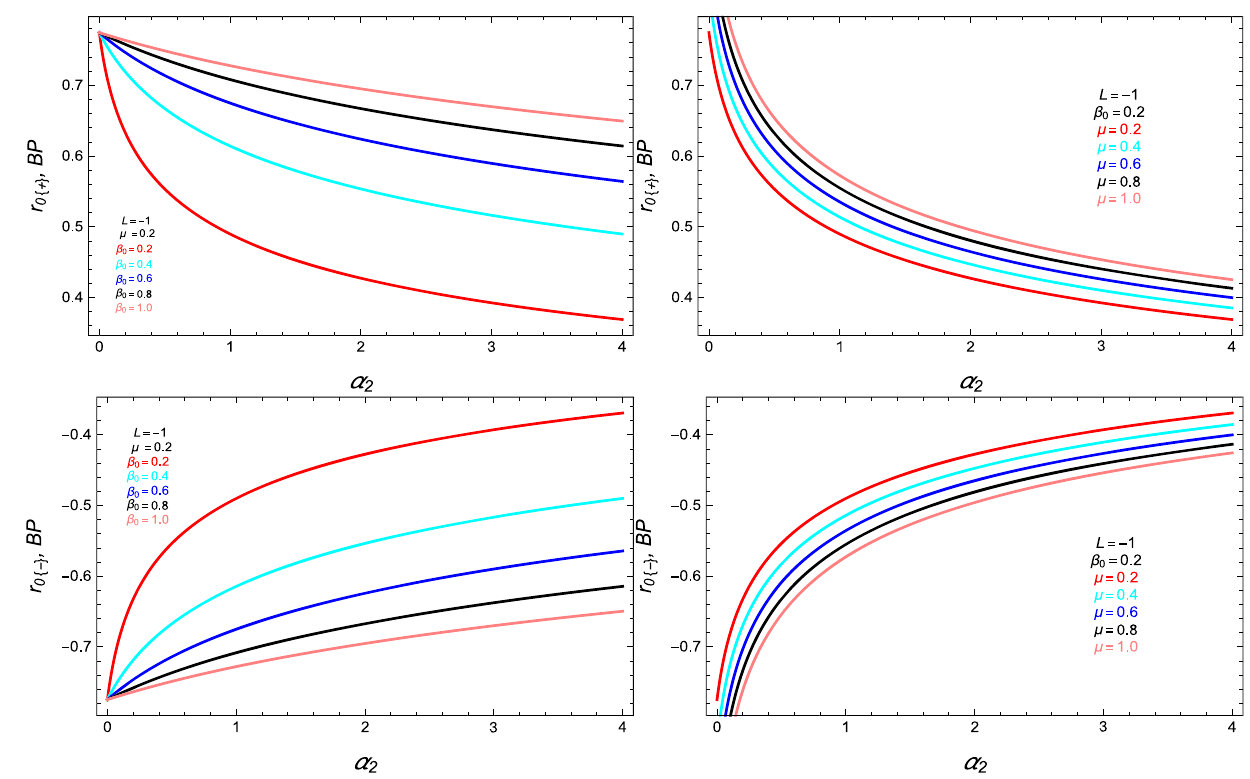
(BP) r 0 {+} , and r 0 {−} (up and down) plots along α 2 for by fixing L = − 1 , β 0 = 0 . 2 for different values of μ {right